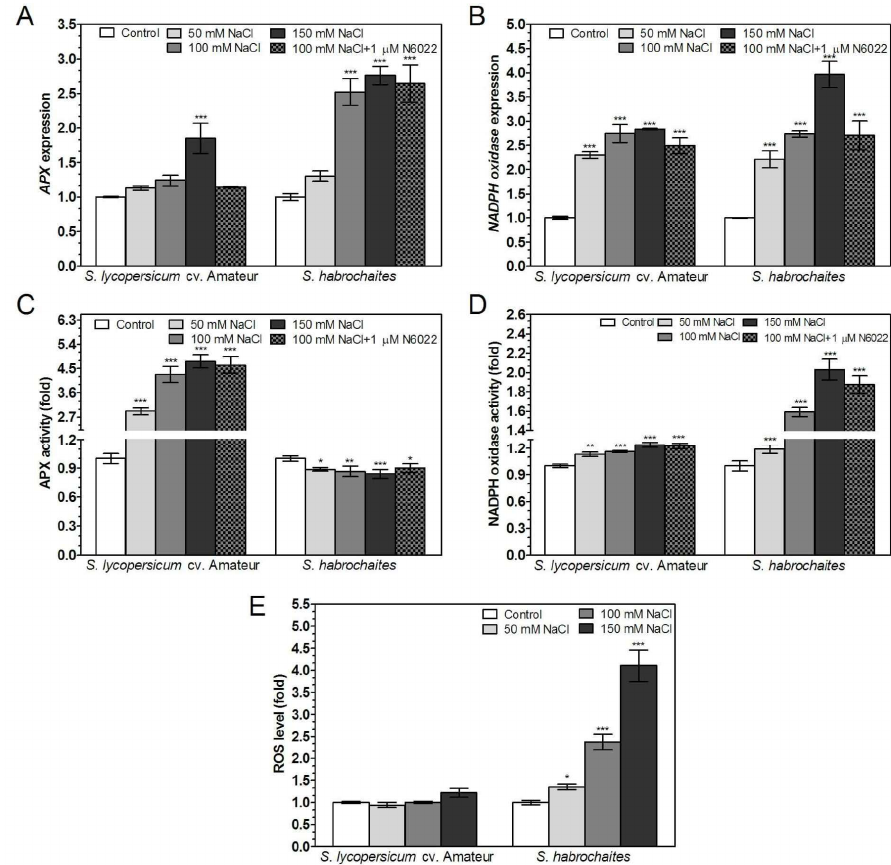
Figure 7. APX and NADPH oxidase gene expression, enzyme activity and ROS levels in two Solanum spp. genotypes exposed to salinity stress. Relative APX and NADPH oxidase gene expression during exposure to 50, 100, 150 mM NaCl or combination of 100 mM NaCl with 1 µ M N6022 was determined by qPCR. ( A ) APX and ( B ) NADPH oxidase expression were normalized to GAPDH and EF1 α mRNA levels. ( C ) APX activity was evaluated spectrophotometrically at 25 ◦ C by monitoring the consumption of H 2 O 2 at λ = 290 nm. ( D ) NADPH oxidase-catalysed O 2 − generation in purified membrane fractions of tomato roots was determined spectrophotometrically at 25 ◦ C by reduction of the tetrazolium salt XTT. ( E ) Quantification of detected ROS levels in root apical parts by confocal microscopy using 20 µ M H 2 DCF DA was performed by ImageJ 1.33 software. The data are presented as means ± SD ( n ≥ 3) relative to the gene expression level / signal intensity measured for unstressed control, given as 1. Significantly di ff erent means from the control are denoted by asterisks (ANOVA, * p < 0.05, ** p < 0.01, *** p < 0.001).